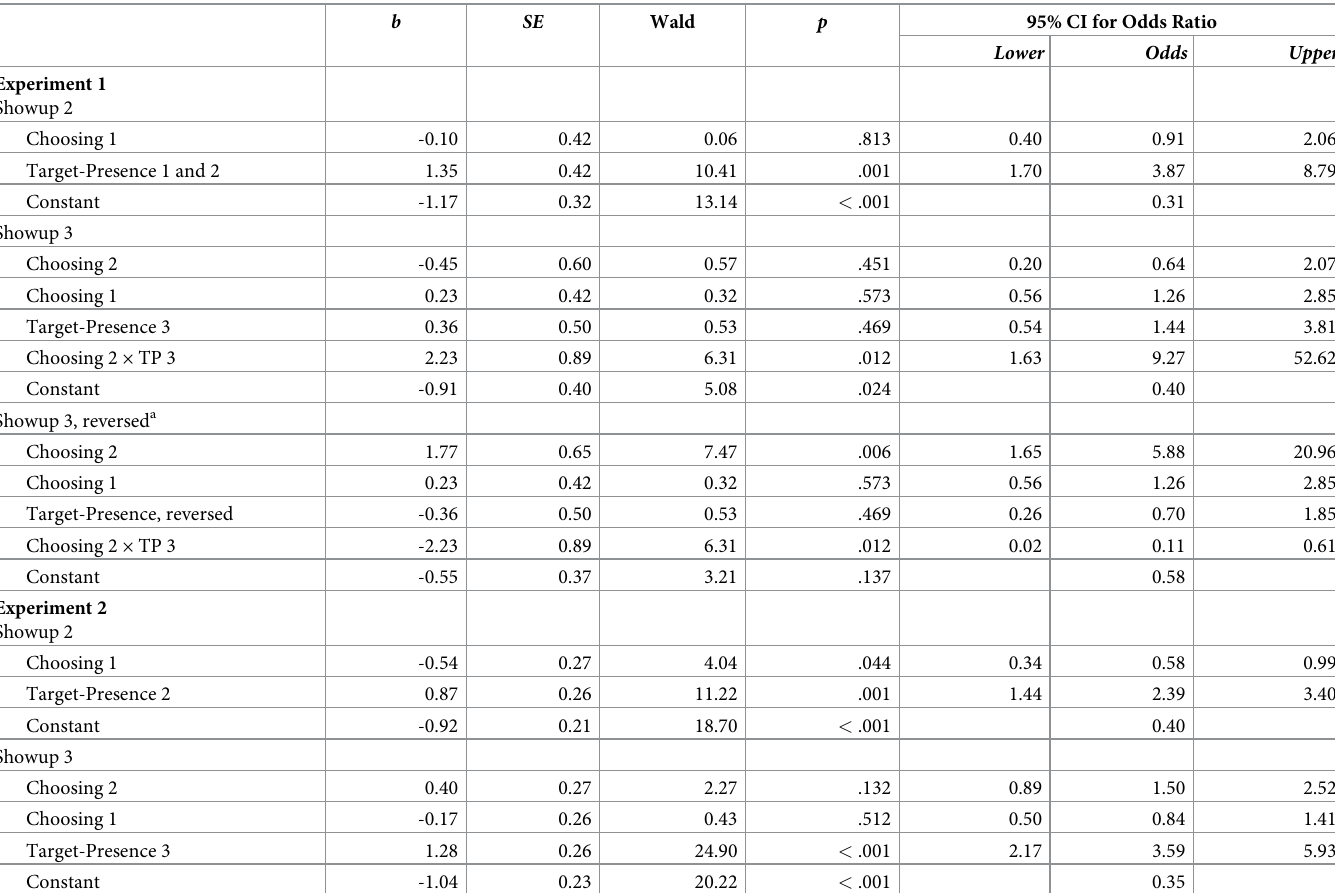
Table 3. Experiments 1 and 2: Final models of logistic regressions predicting choosing on showups 2 and 3 based on previous choosing and